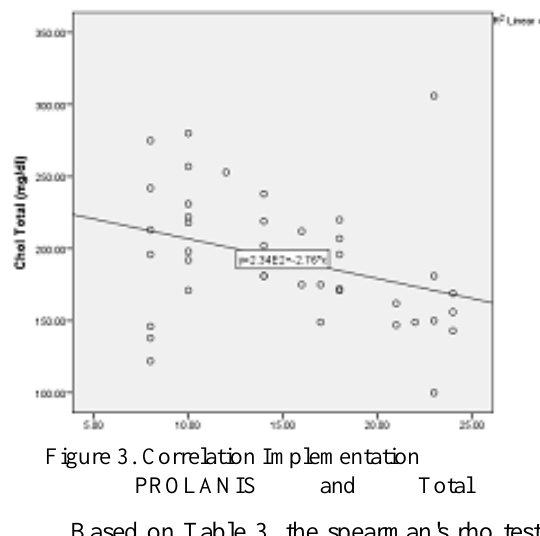
Figure 3. Correlation Implementation PROLANIS and Total